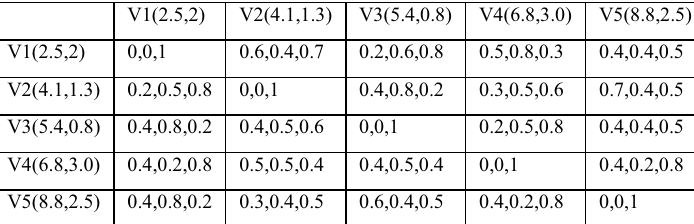
Table: 4 show that the QOS values of each node with all possible cluster